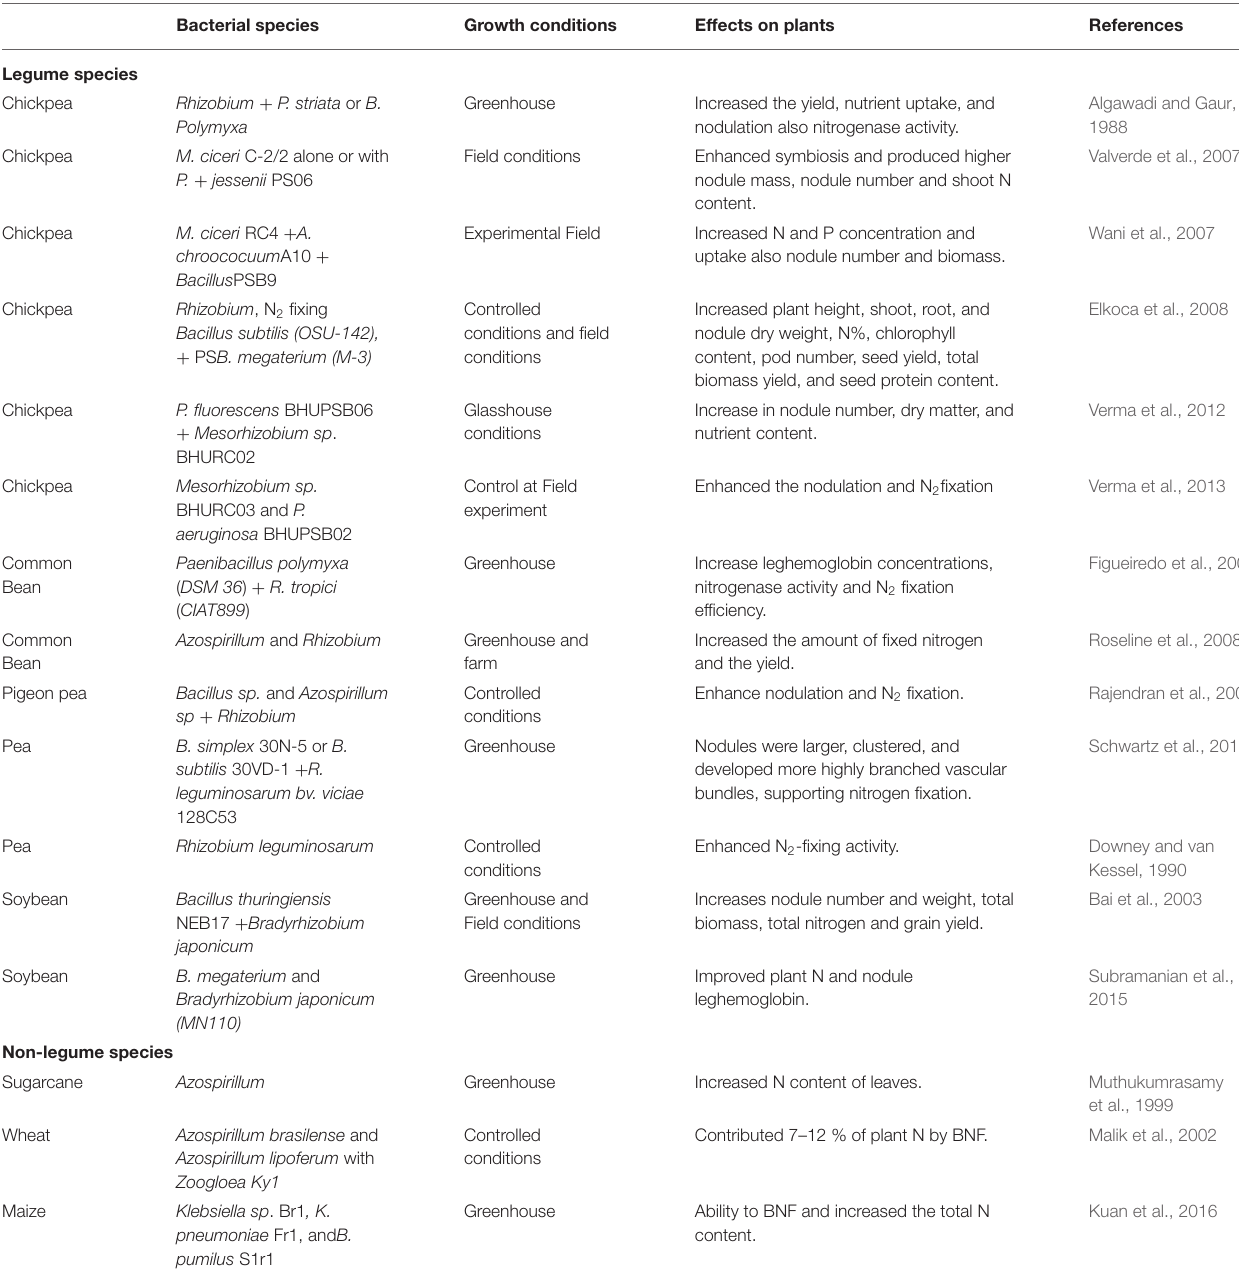
TABLE 1 | Effects of phosphate solubilizing microorganisms on grain legumes growth, biological nitrogen fixation and nutrient